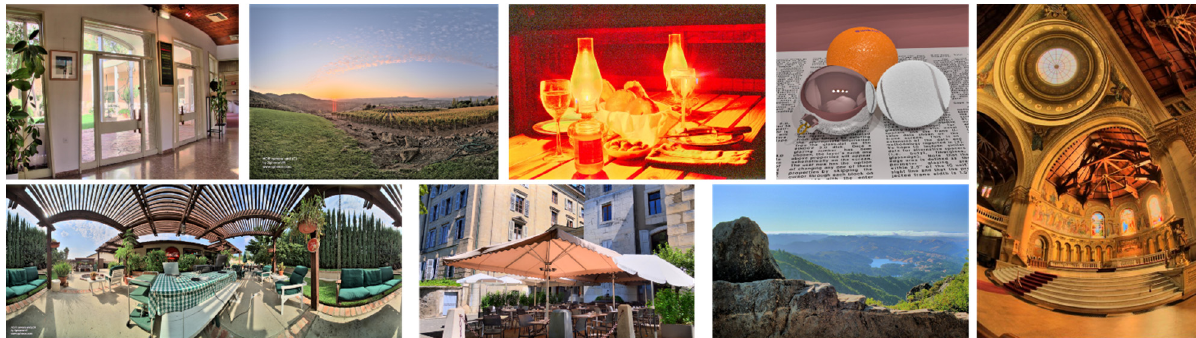
Figure 10. Thumbnails of partial test images with corresponding information provided in Table 2. First row from left to right: test images no. 1, no. 4, no. 6, and no. 5. Second row from left to right: test images no. 21, no. 17, and no. 3. Right side: test images no. 22. All the images are processed using the proposed method. Table 2. List of twenty-two test images and their dynamic ranges (D).